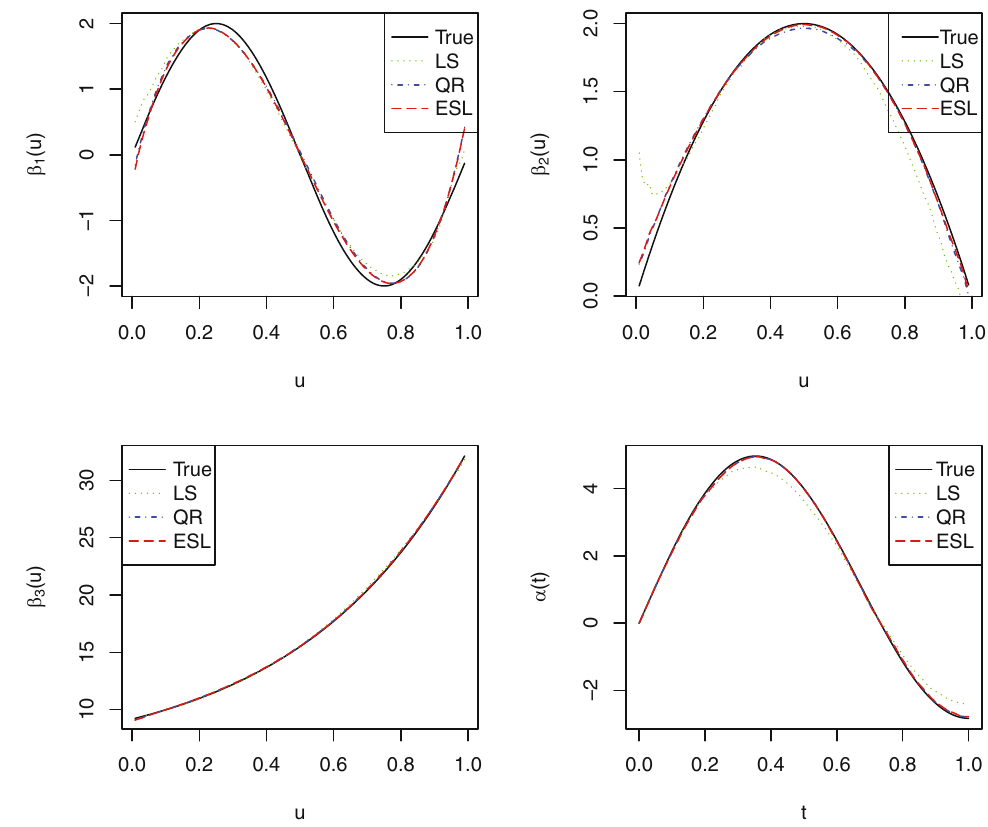
, = j 1, 2, 3 and ( ) α t when j